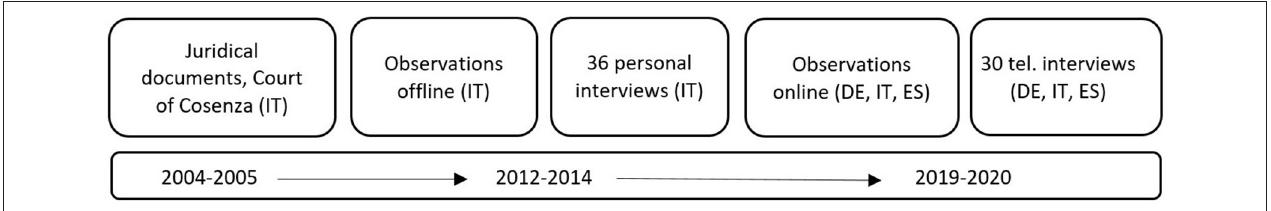
FIGURE 1 | Overview of methodology and